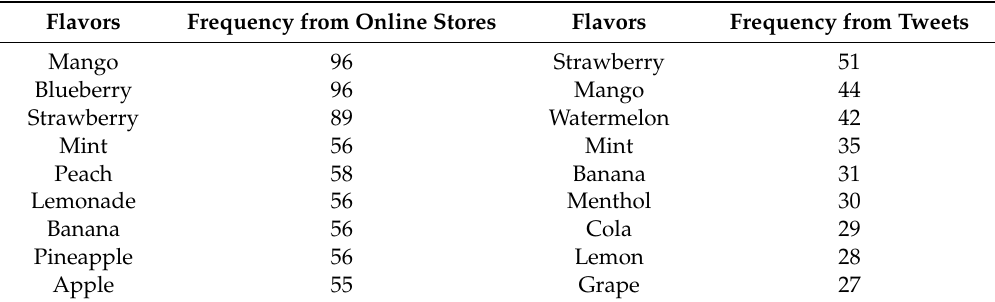
Table 1. Popular flavors in disposable e-cigarettes.